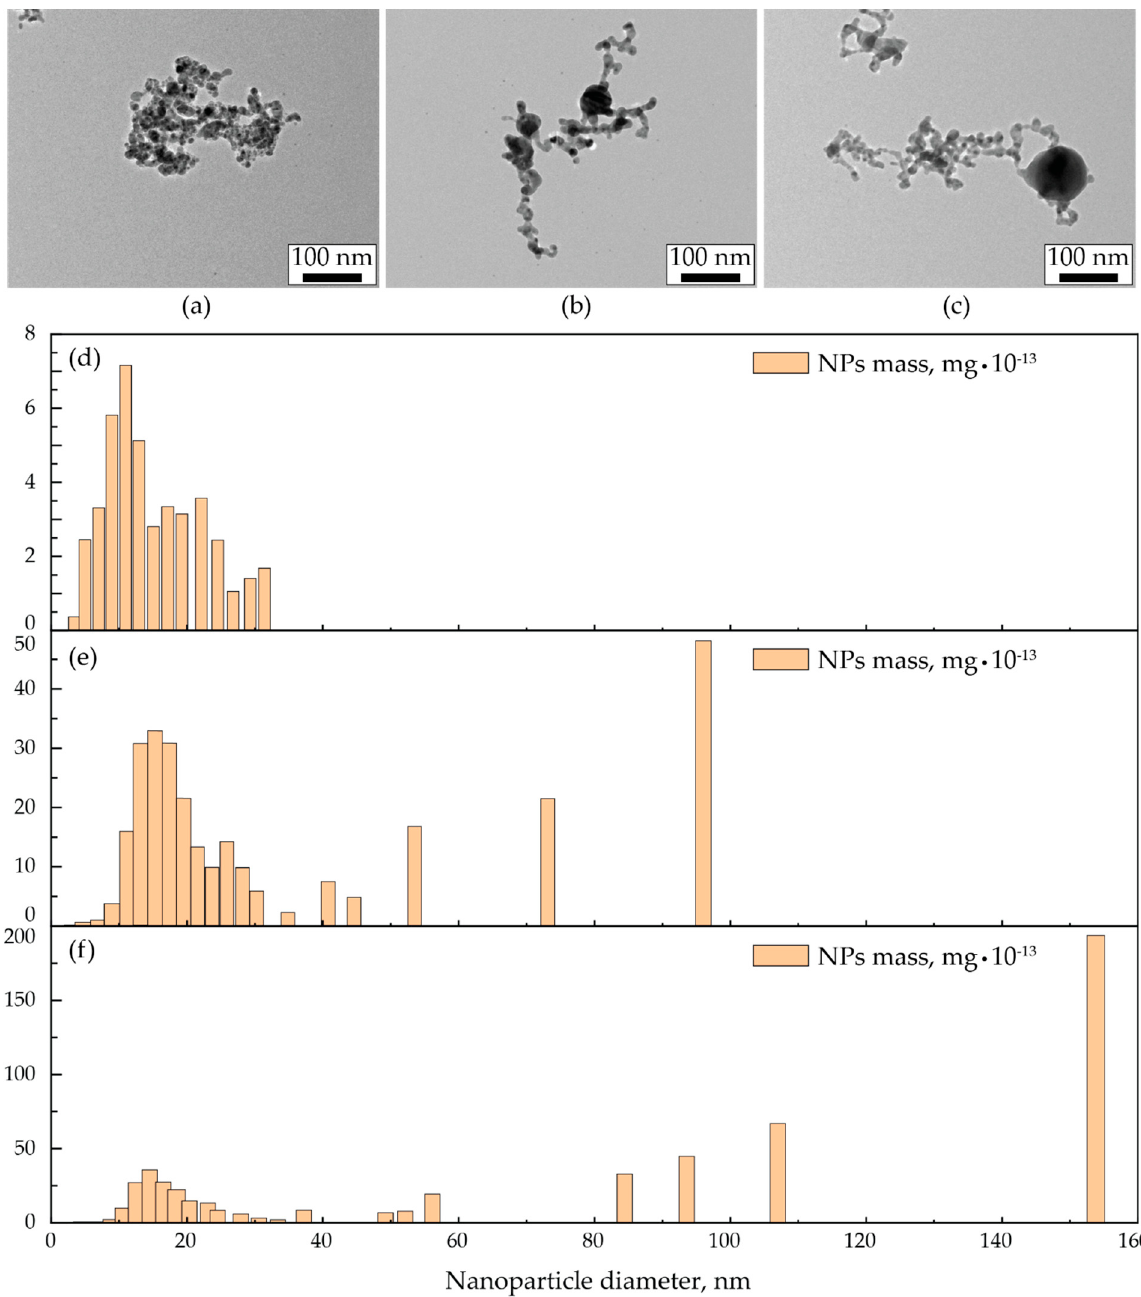
Figure 8. ( a – c ) TEM images and ( d – f ) mass distributions of NPs for the synthesis with the ODP and electrodes ends arranged ( a , d ) parallel and at the angles of ( b , e ) 7° and ( c , f ) 15°.